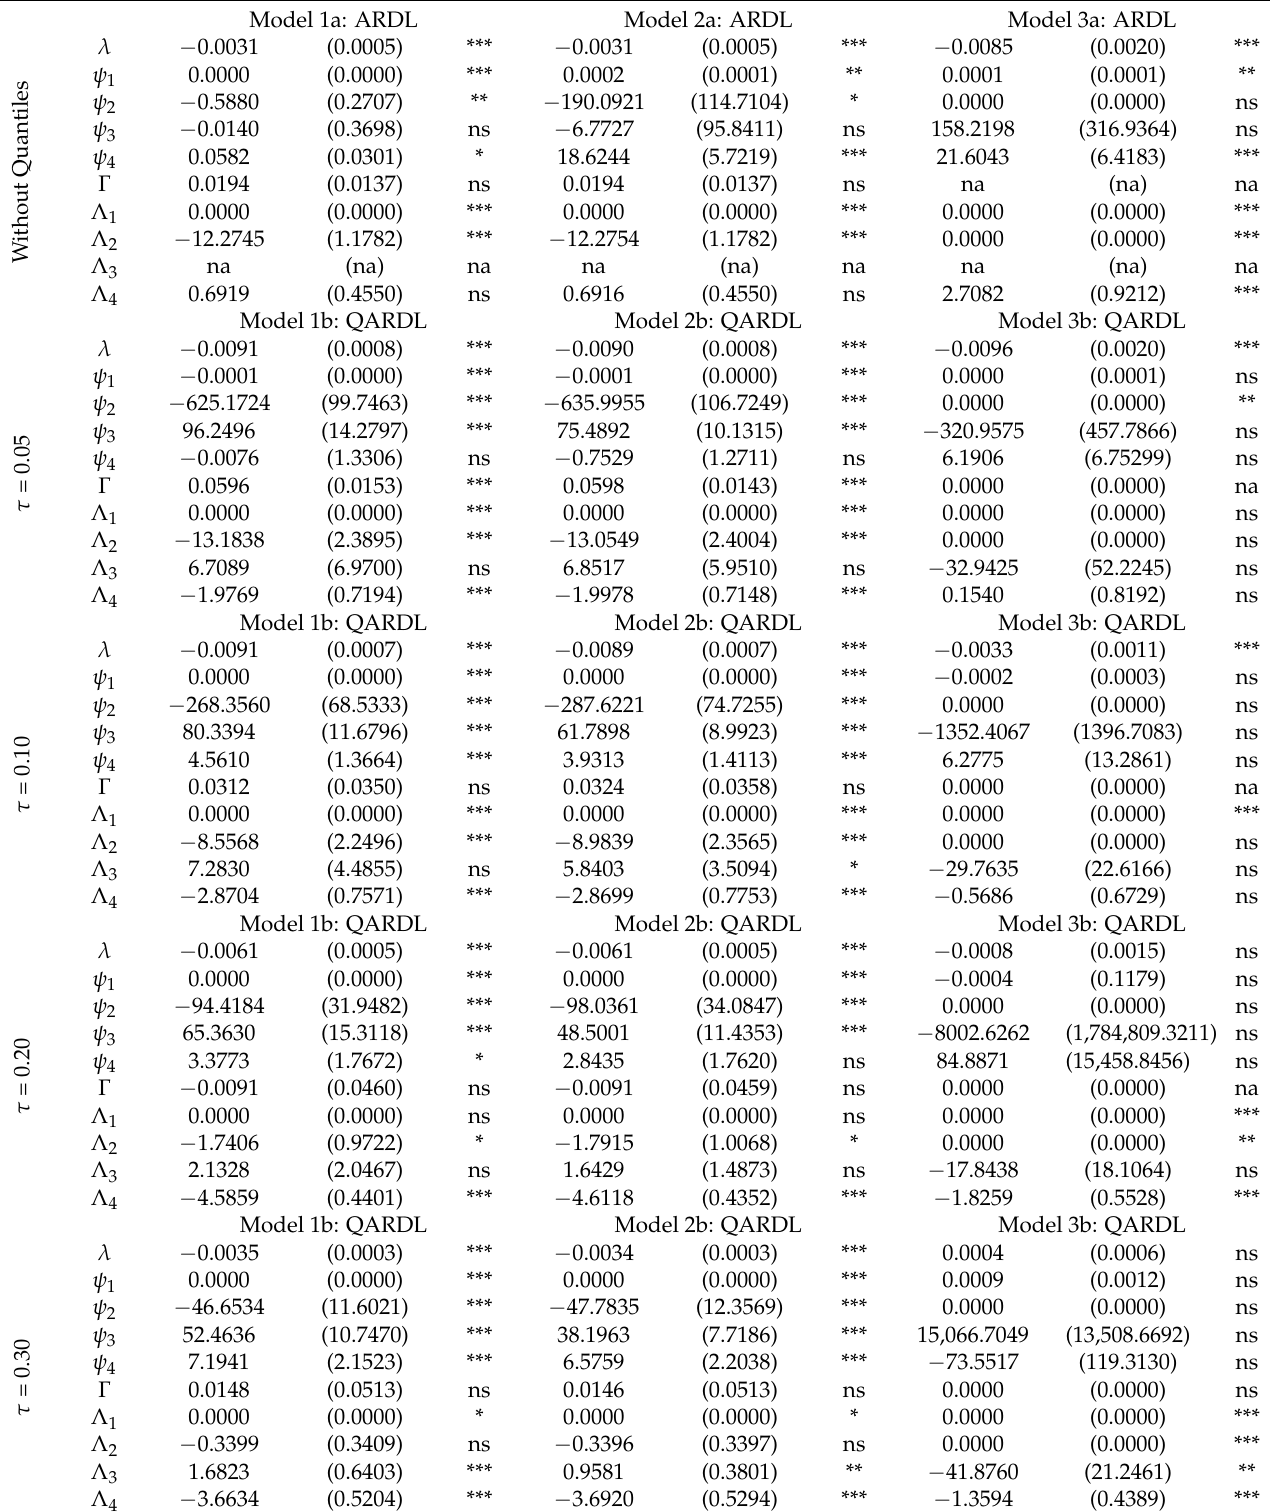
Table 5. ARDL and QARDL model estimation